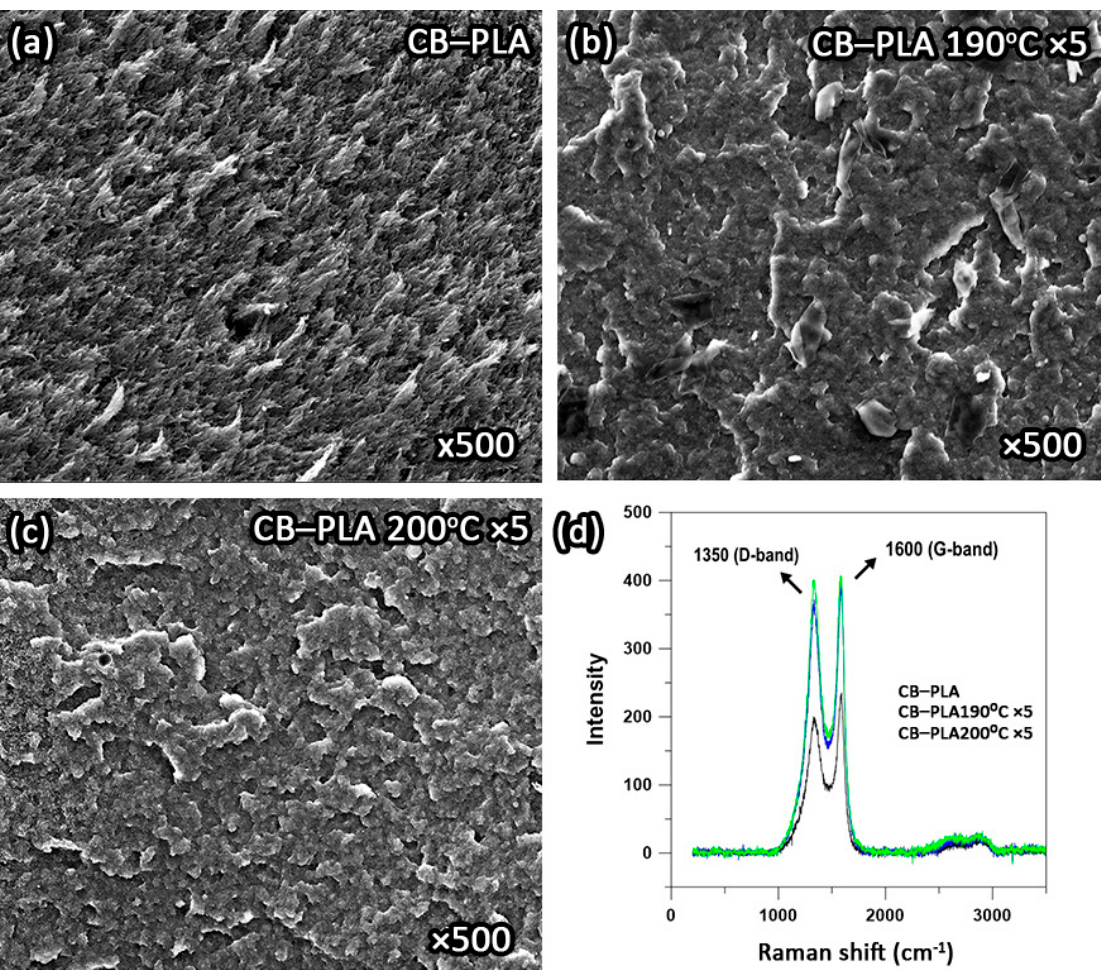
Figure 5. SEM micrographs of ( a ) reference sample, five-time reprocessed CB–PLA at ( b ) 190 °C, ( c ) 200 °C, and ( d ) Raman spectra of the pristine CB–PLA and after five reprocessing cycles. The samples after reprocessing no longer show such an irregular structure. The